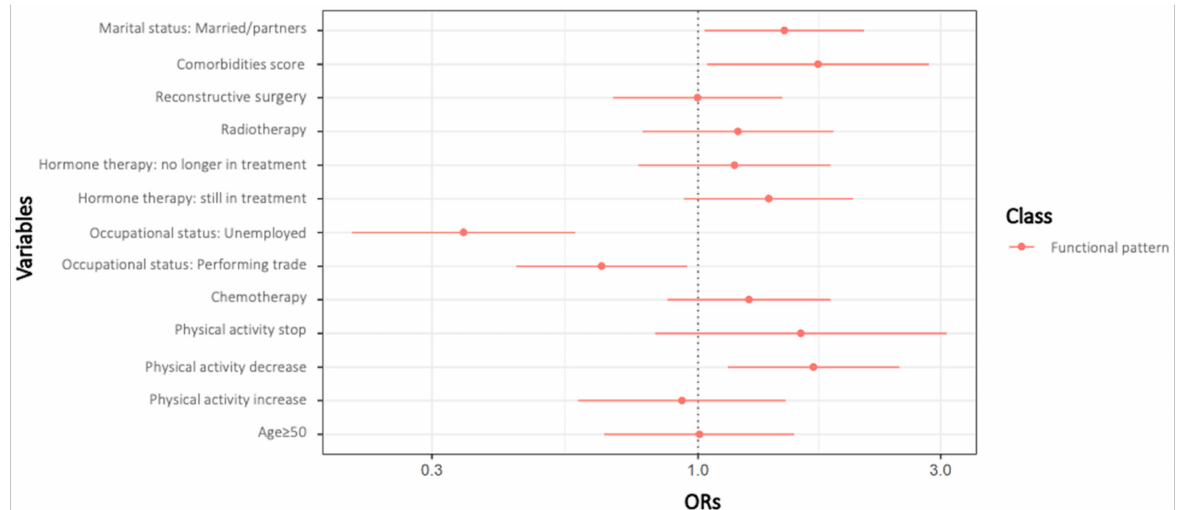
Figure 4. Adjusted multinomial logistic regression analysis ( n =